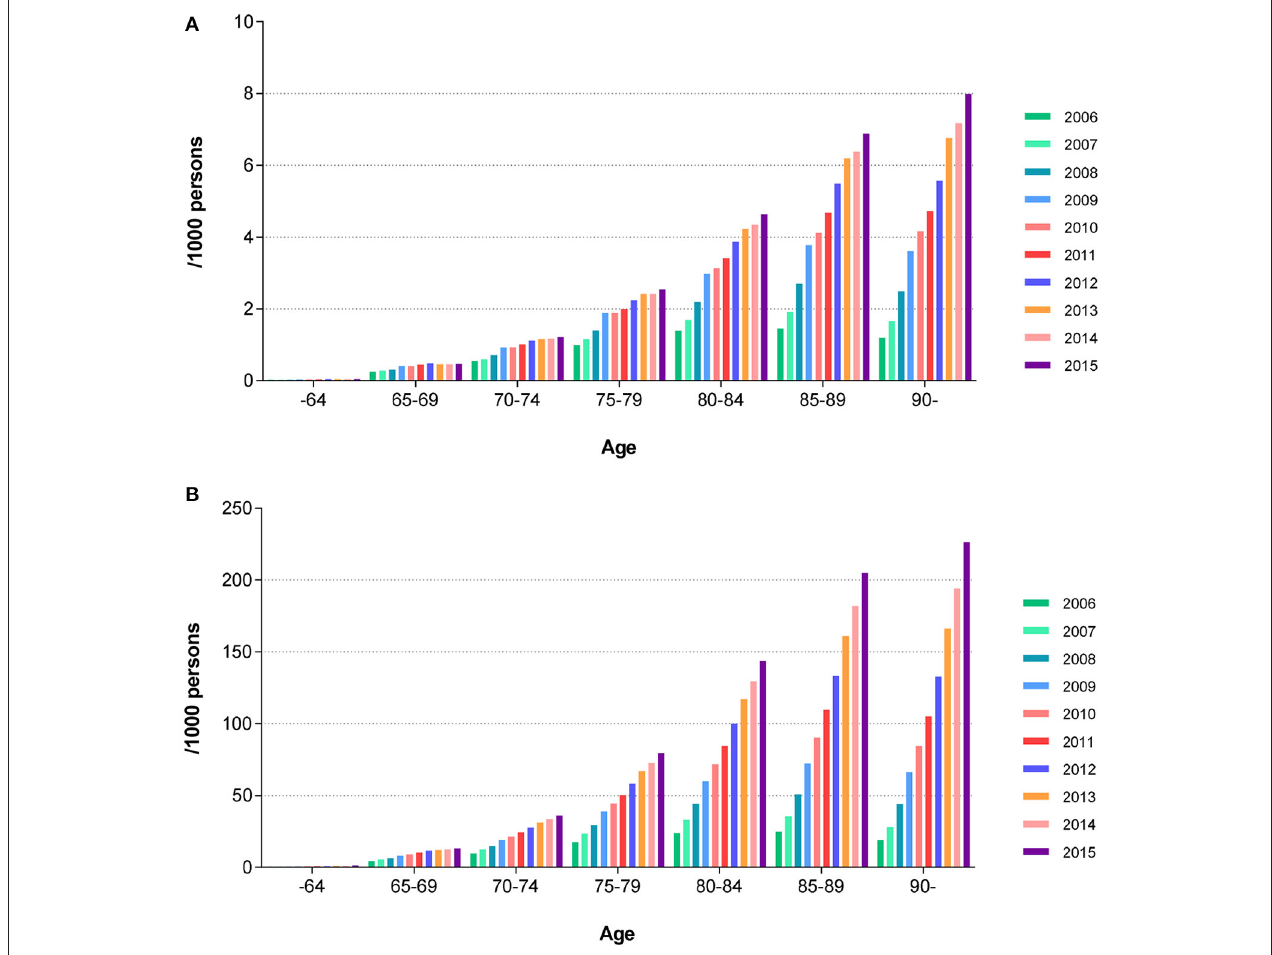
FIGURE 1 | Sex standardized age-specific annual trends in the prevalence and incidence of AD. (A) Incidence of AD. (B) Prevalence of AD. AD, Alzheimer’s disease.